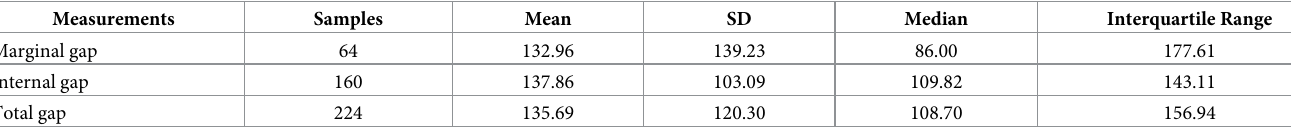
Table 2. Descriptive statistical analysis of marginal and internal gaps ( μ